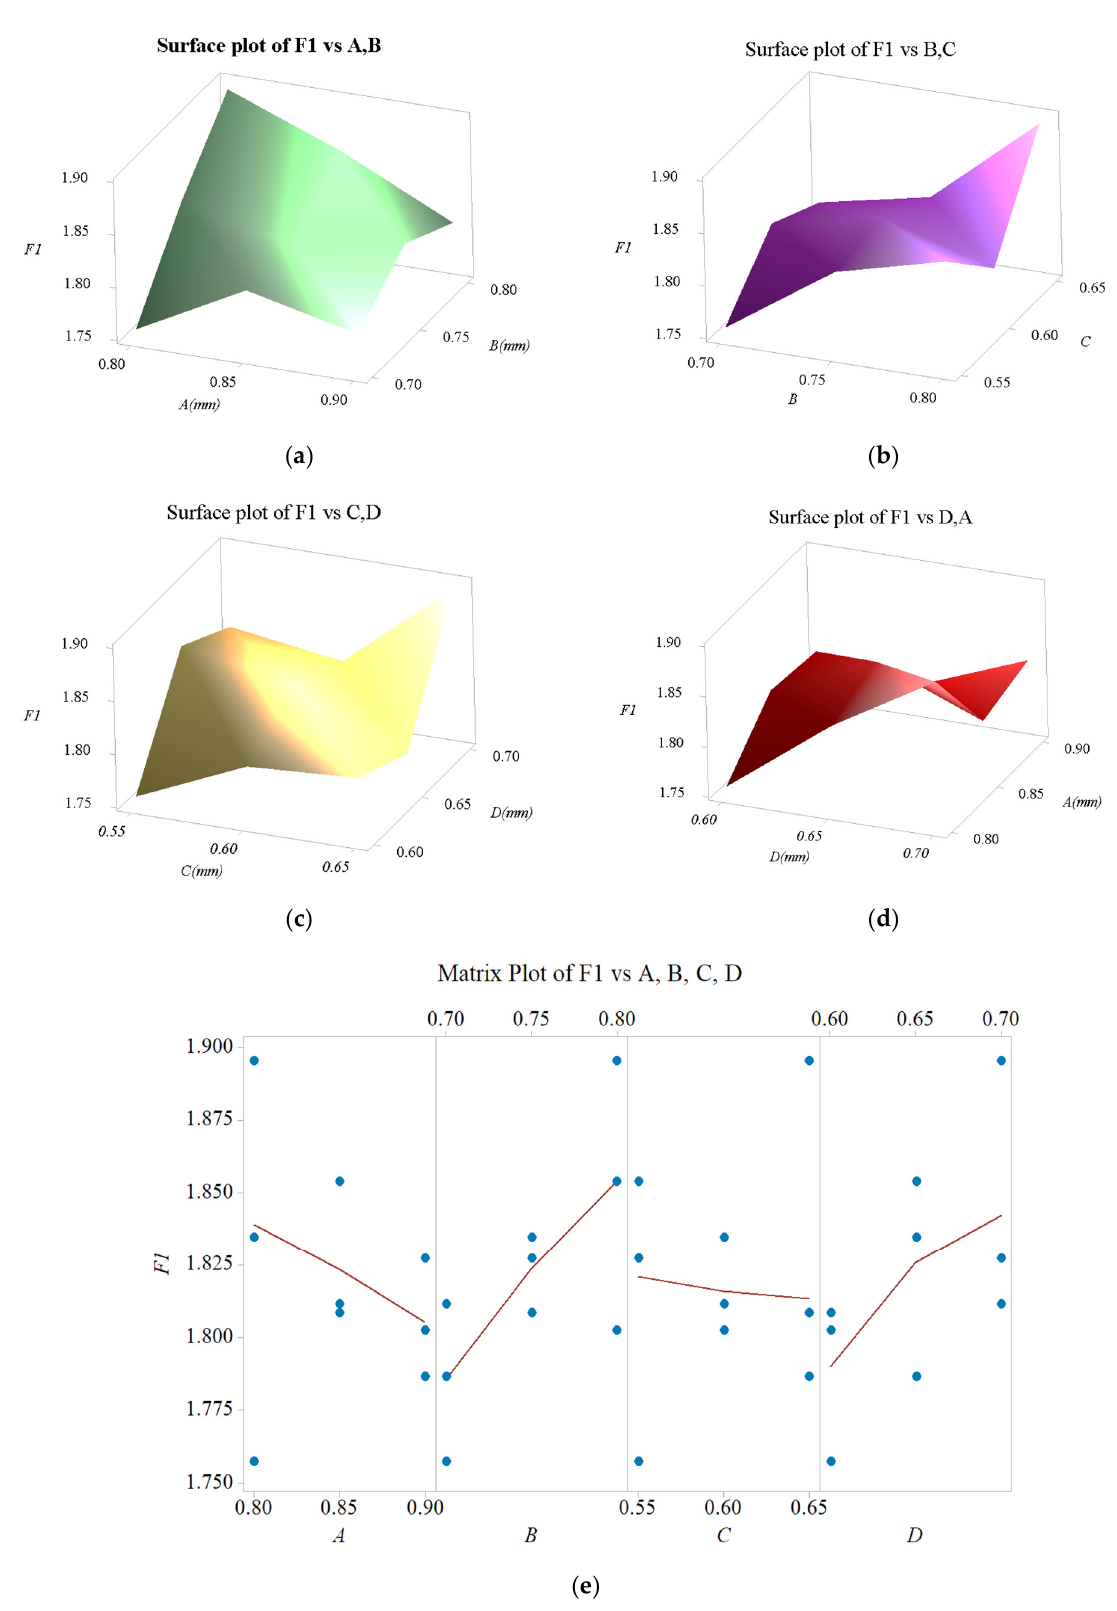
Figure 14. Influence diagram on safety factor: ( a ) of A and B, ( b ) of B and C, ( c ) of C and D, ( d ) of D and A, and ( e ) of A, B, C and D.